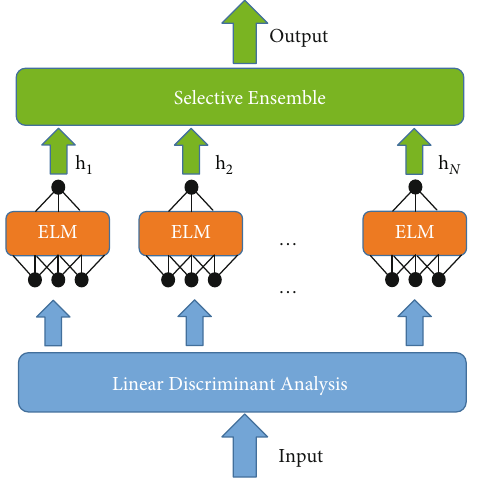
Figure 1: Block diagram of the LDA-ELM